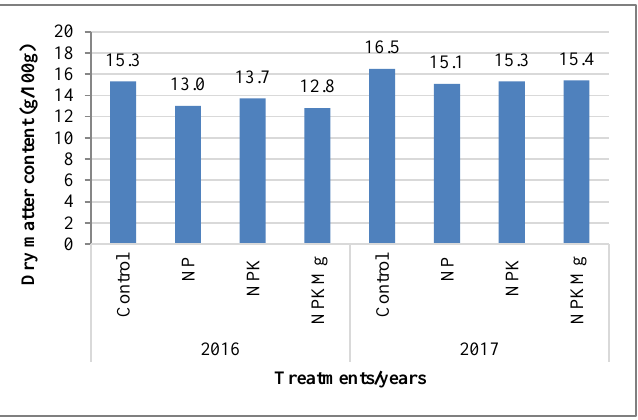
Figure 4 . Dry matter content of the fruits (Debrecen-Pallag, 2016-2017).